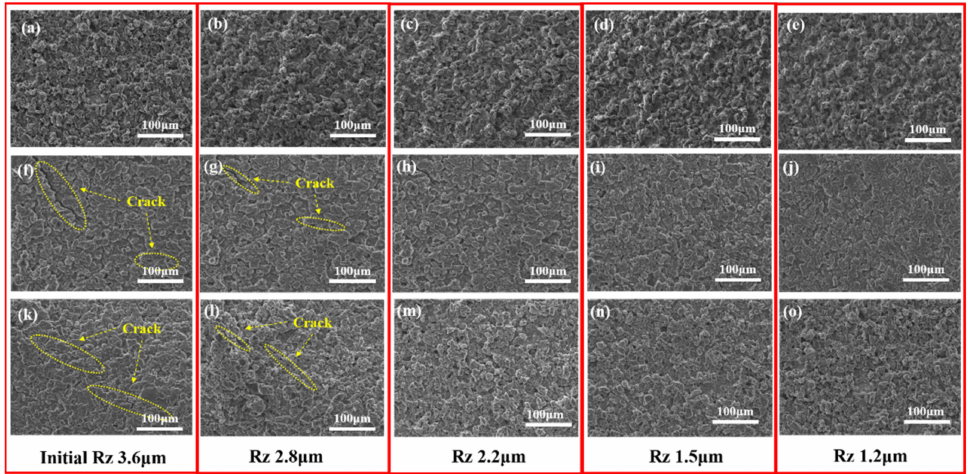
Figure 6. SEM images for a surface of graphite electrode: ( a – e ) before cycle test, ( f – j ) after 100 cycles at 0.5 C, ( k – o ) after 100 cycles at 2